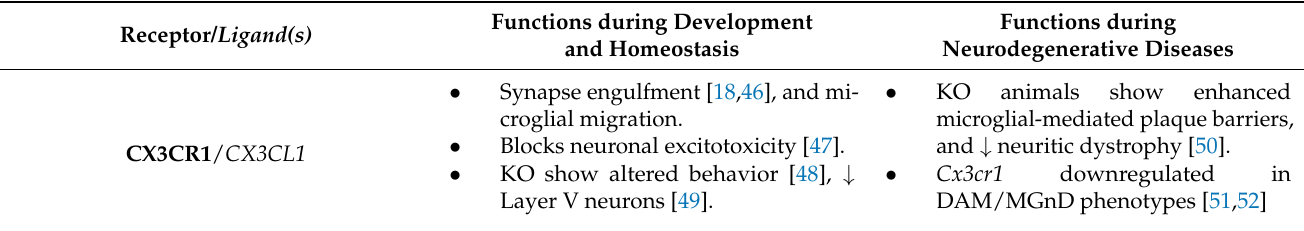
Table 1. Overview of selected microglial receptors and signaling molecules during development, homeostasis and neurode- generative